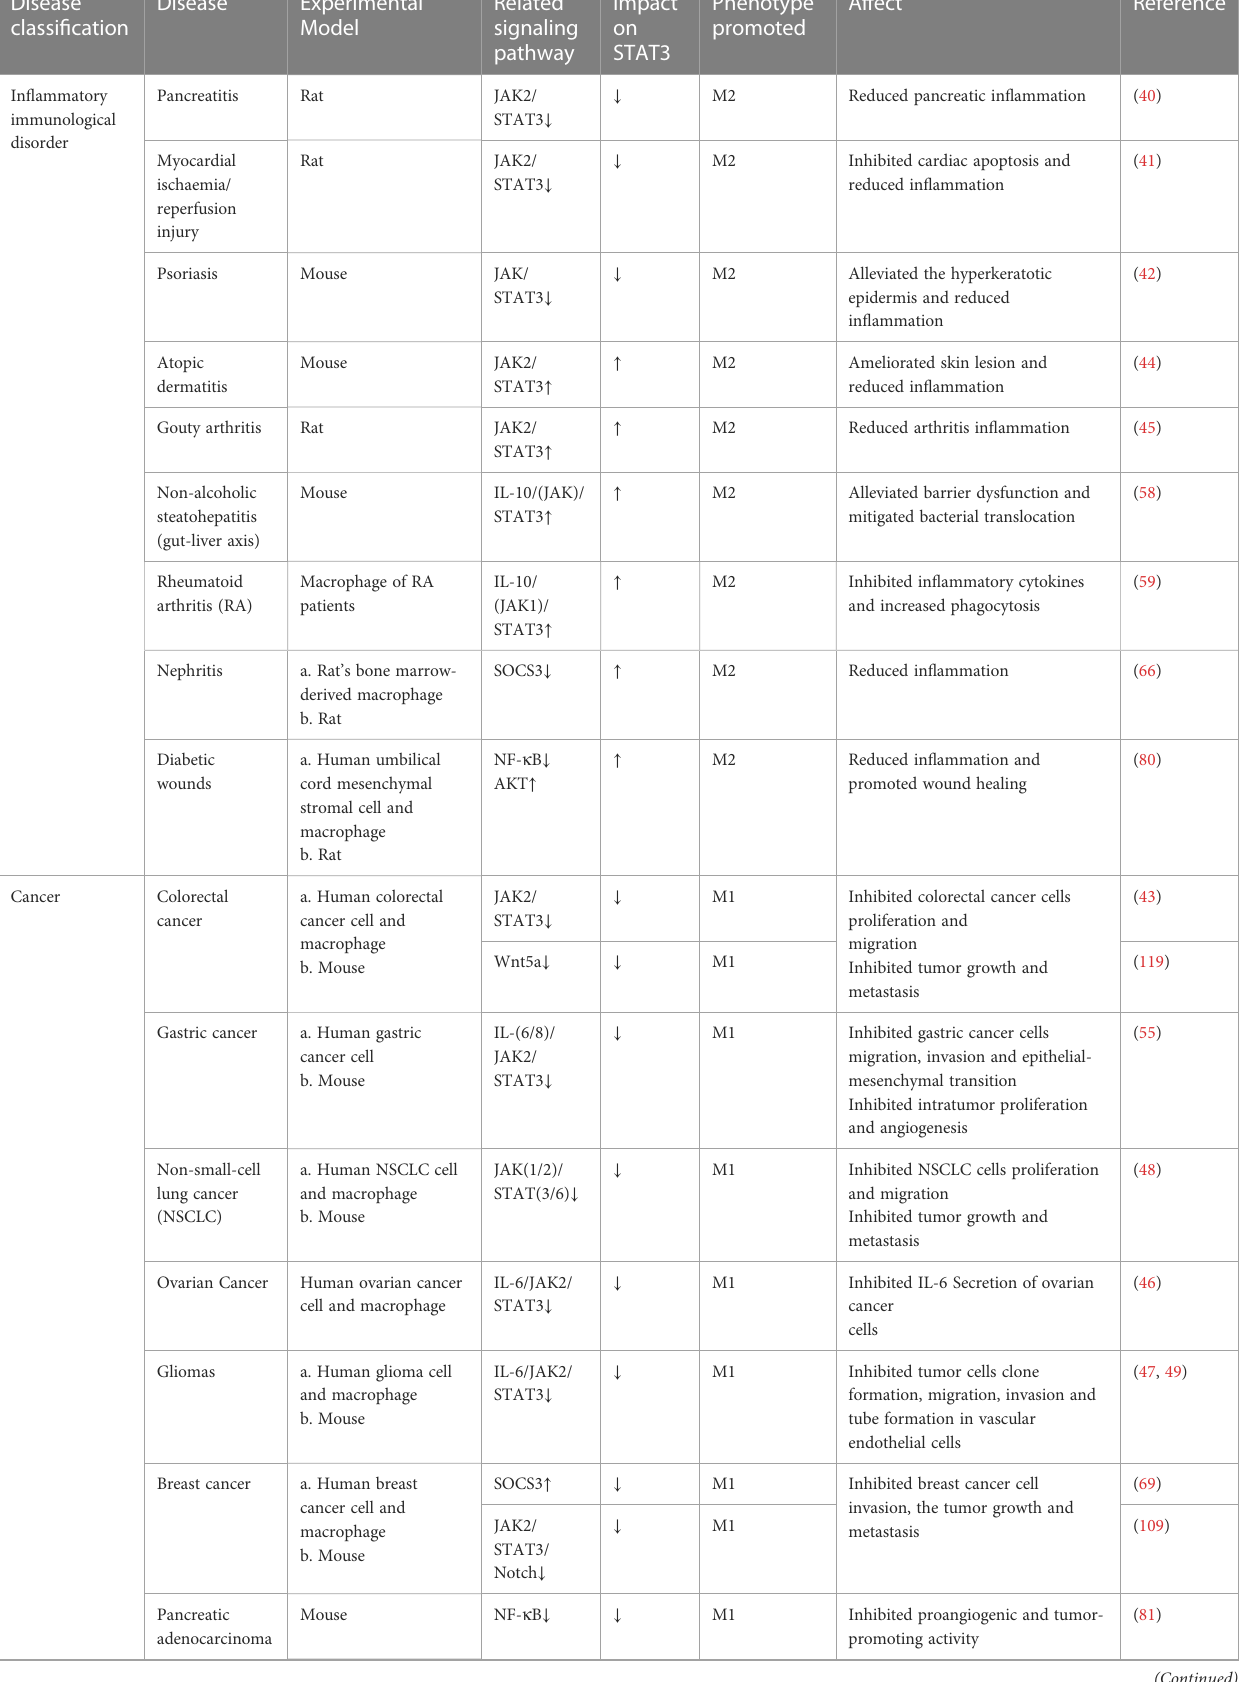
TABLE 1 Regulation of macrophage polarization by targeting STAT3 for the treatment of related